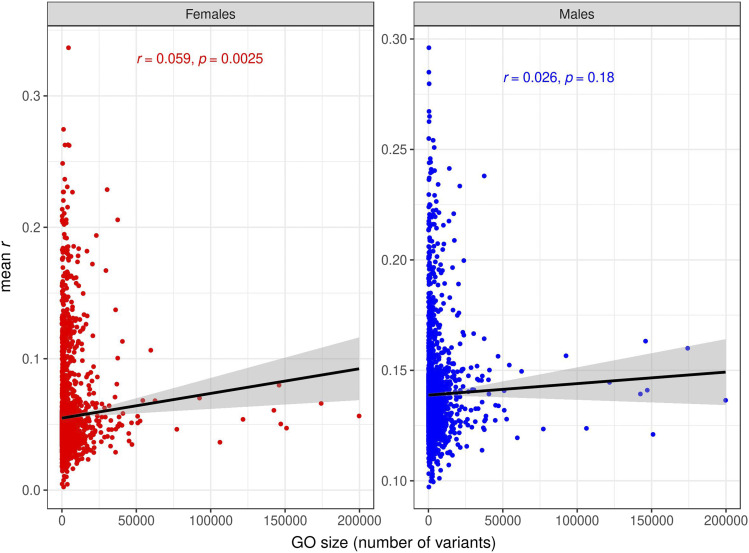
Relationship between prediction accuracy obtained by the GO-GBLUP model, measured as mean r (on the y-axis) in the test set, and size of the GO terms, measured as number of variants (on the x-axis), for starvation resistance. Each point represents a specific GO term. The black line represents the linear regression fit. The left panel represents females, and the right panel represents males.